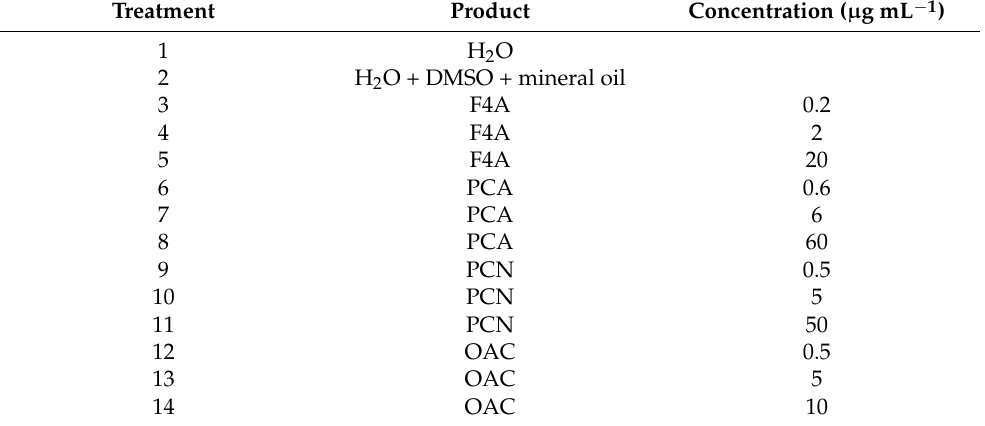
Table 2. Description of treatments used in the severity experiment, the products used and the respective